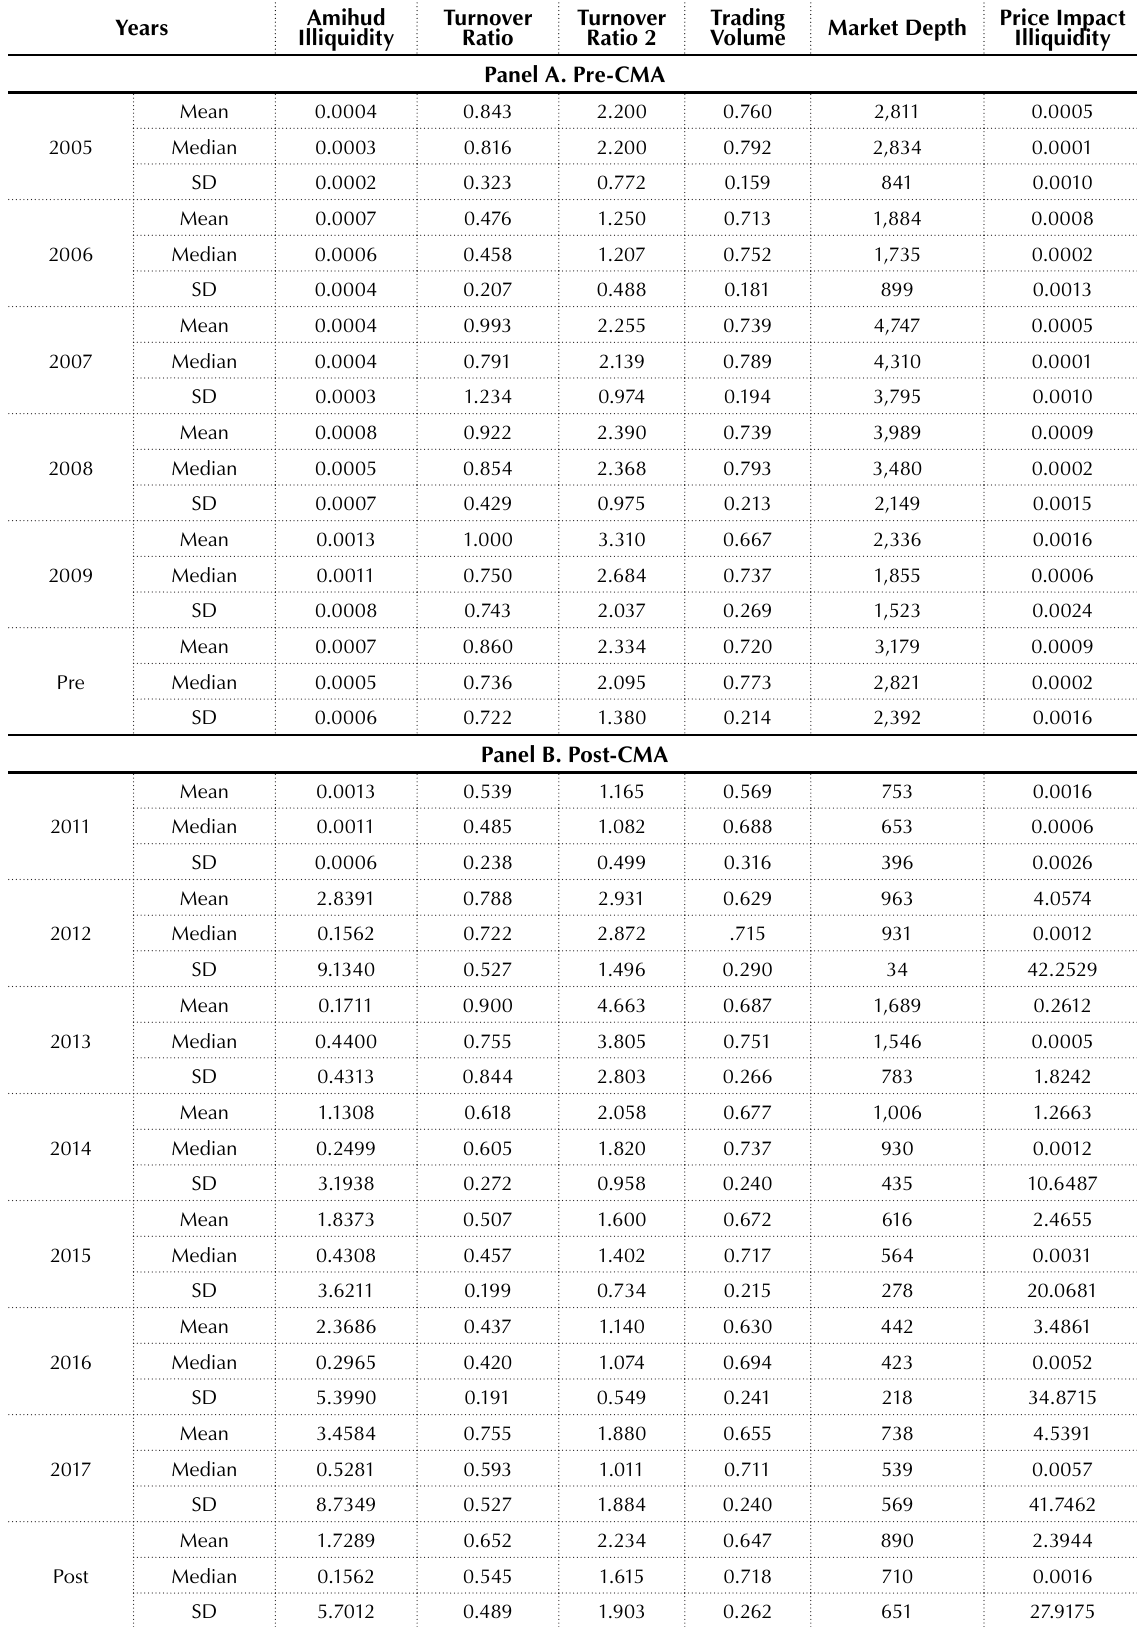
Table 2. Summary statistics of all the liquidity measures in the pre-post CMA Law period Years